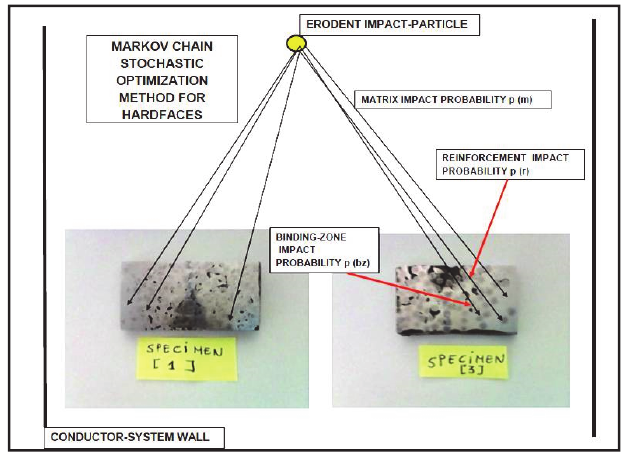
Fig. 15. Setting the impact probability for WC-Co hardfaces. Namely, matrix, p ( m ), reinforcement, p ( r ), and binding zone, p ( b z ). On the right, spherical hardface manufactured, and on the left, polygonal reinforcement hardface with recycled